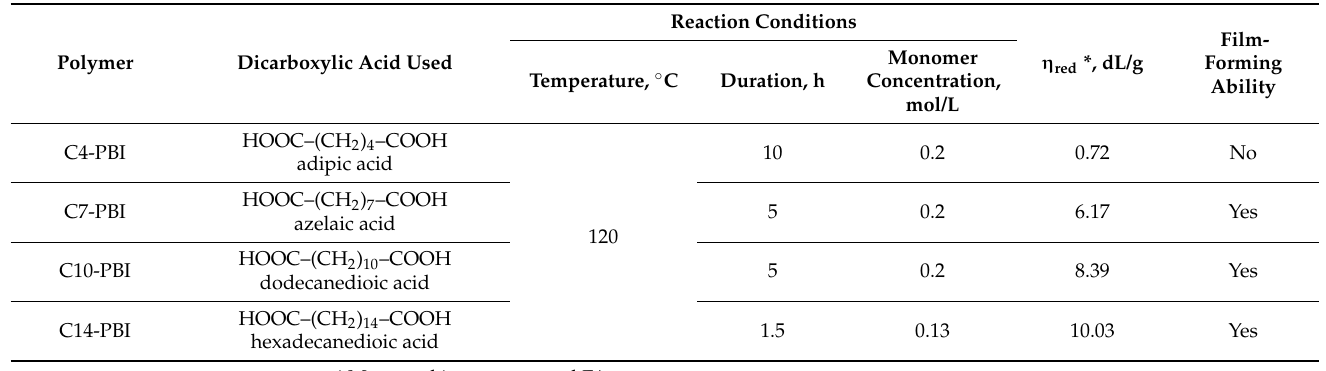
Table 1. Conditions of PBIs’ synthesis.